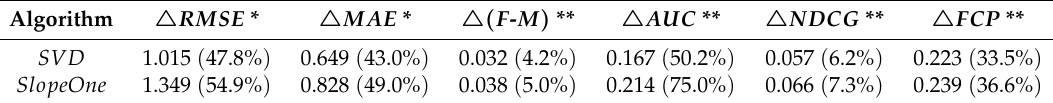
Table 10. Level of accuracy improvement between MC - SVD and the single rating techniques.